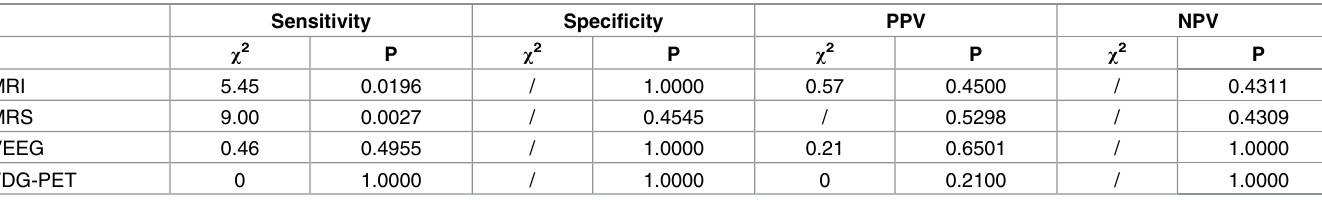
Diagnostic values of the three RS-fMRI indexes Tables 4 and 5 summarize the EZ localization results for ReHo, ALFF, and fALFF. As shown in these tables, ReHo was superior or identical to ALFF and fALFF in the accuracy for EZ localization. Table 5 summarizes the diagnostic values of ReHo, ALFF, and fALFF based on the compre- hensive evaluation. ReHo had higher sensitivity (69.4%) and NPV (26.7%) than ALFF (52.8% and 22.7%, respectively) and fALFF (38.9% and 15.4%, respectively); ALFF had higher specific- ity (83.3%) and PPV (95.0%) than ReHo (66.7% and 92.6%, respectively) and fALFF (66.7% and 87.5%, respectively). ReHo and ALFF had the same YI (0.36), which was superior to that of fALFF (0.06). Table 6 summarizes the statistical differences among the three RS-fMRI indexes in terms of sensitivity, specificity, PPV, and NPV. No significant differences were observed between